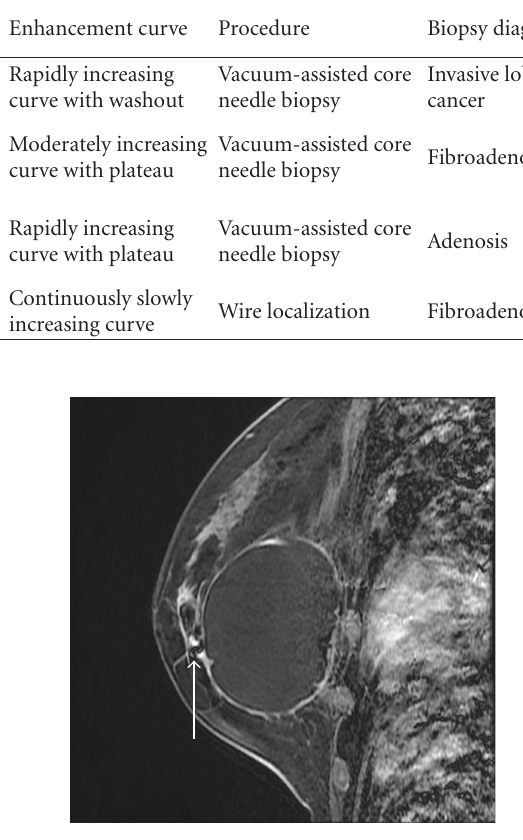
Figure 4: Sagittal postcontrast breast MRI of an augmented breast with silicone injection and mammoplastic bag placement showed a 0.8 cm lobular mass beneath the augmented mammoplasty bag, with placement of an MRI-compatible guide wire (white arrow) for excision